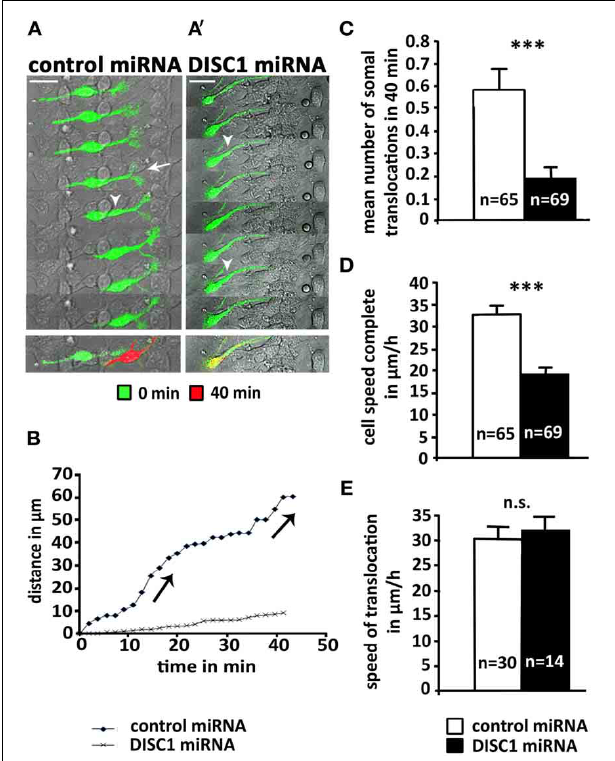
FIGURE 3 | DISC1 deficient cells perform less somal translocations in vitro . (A, A (cid:2) ) Time line of interneurons expressing control miRNA (A) or DISC1 miRNA (A (cid:2) ) on a cortical feeder-layer. Arrow heads indicate swellings, arrows indicate newly built bifurcations. Time interval 10.5min. Overlays of the time points 0min (green) and 40min (red) demonstrate the movement of the cells. Scale bars: 20 μ m. (B) Graphic representation of the movement of cells mapped under (A,A (cid:2) ) . Jumps in the graph indicate somal translocations. In contrast to the control, the DISC1 deficient cells performed no somal translocations within 40min. (C) Analysis of somal translocations per cell in 40min resulted in a decreased number of translocation in DISC1 deficient cells compared to control cells. (D) Analysis of the migration speed in 40min shows a reduction after DISC1 miRNA expression. (E) Analysis of soma translocation velocity revealed no difference. Error bars: s.e.m. Student’s t- test: n.s. p ≥ 0 . 05, ∗∗∗ p < 0 . 001, “n” reflects number of